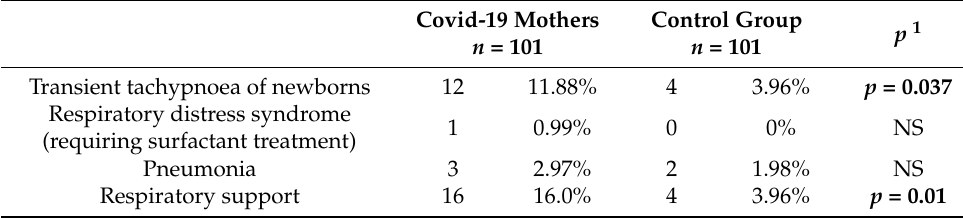
Table 3. Different forms of respiratory distress in the study group and control group.